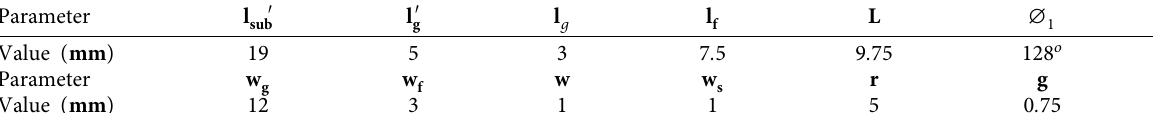
Table 1: Optimized parameters of the proposed